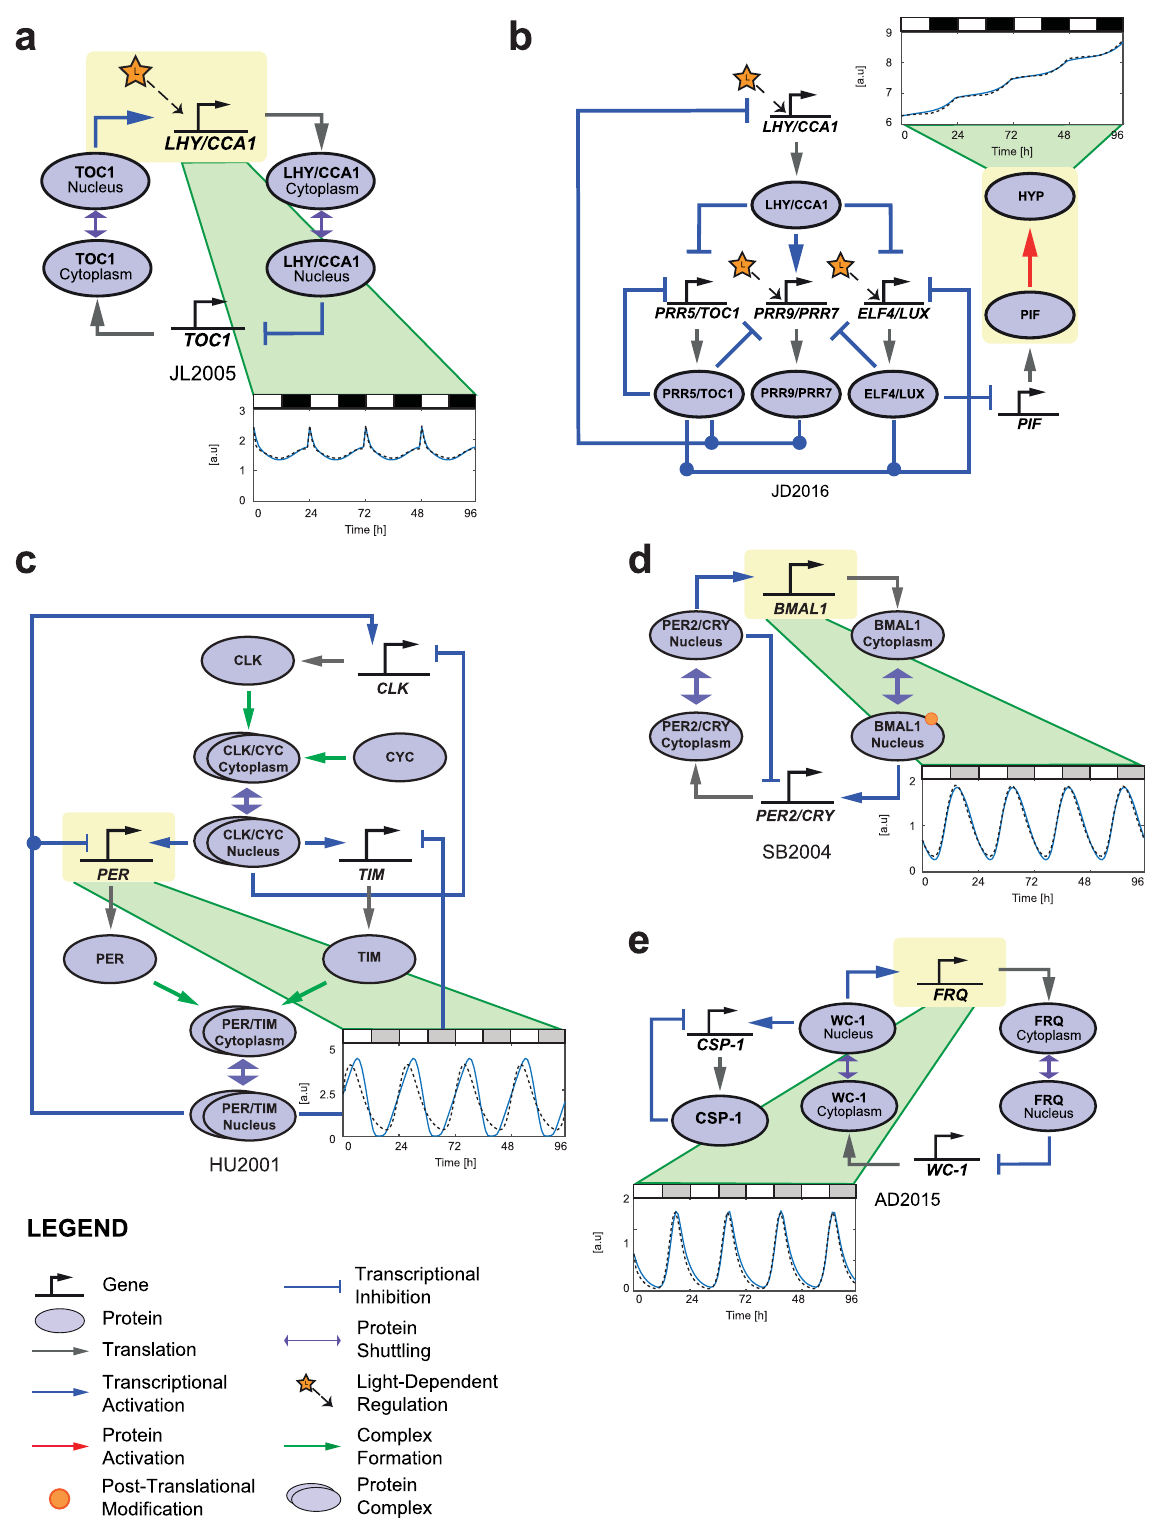
Fig. 1 The plant, mammalian, fungal, and insect circadian clock models. a Plant clock, JL2005 24 . b Plant clock, JD2016 41 . c Insect clock, HU2001 25 . d Mammalian clock, SB2004 27 . e Fungal clock, AD2015 26 . For illustration, only the time series of a single gene component is presented (these components are indicated by yellow boxes). Blue solid line: Simulated time series using the standard Michaelis – Menten model from the respective literature. Black dashed line: Simulated time series using the extended S-System model. White, black, and gray rectangular boxes at the top of the fi gures correspond to light, dark, and subjective dark intervals, respectively. For the full comparison of all the clock genetic components, see Supplementary Figs. 2 – 6.